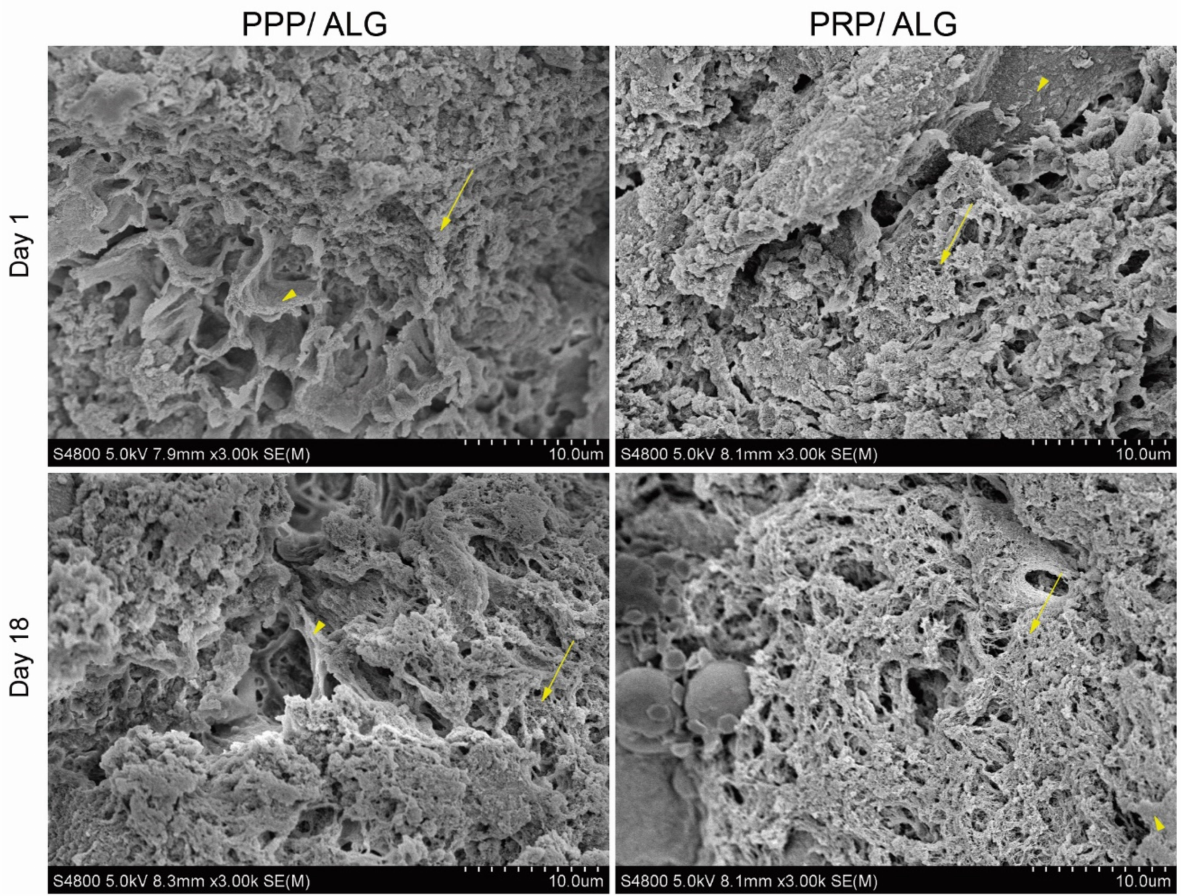
Figure 3. Scanning electron microscopy micrographs of PPP/ALG and PRP/ALG advanced dressings taken on days 1 and 18 following bioprinting. Fibrin fibers are indicated by arrows, and alginate is indicated by arrowheads. Original magnification, 3.00 × k. Scale bar, 10 µ m. PPP, platelet-poor plasma; PRP, platelet-rich plasma; ALG,